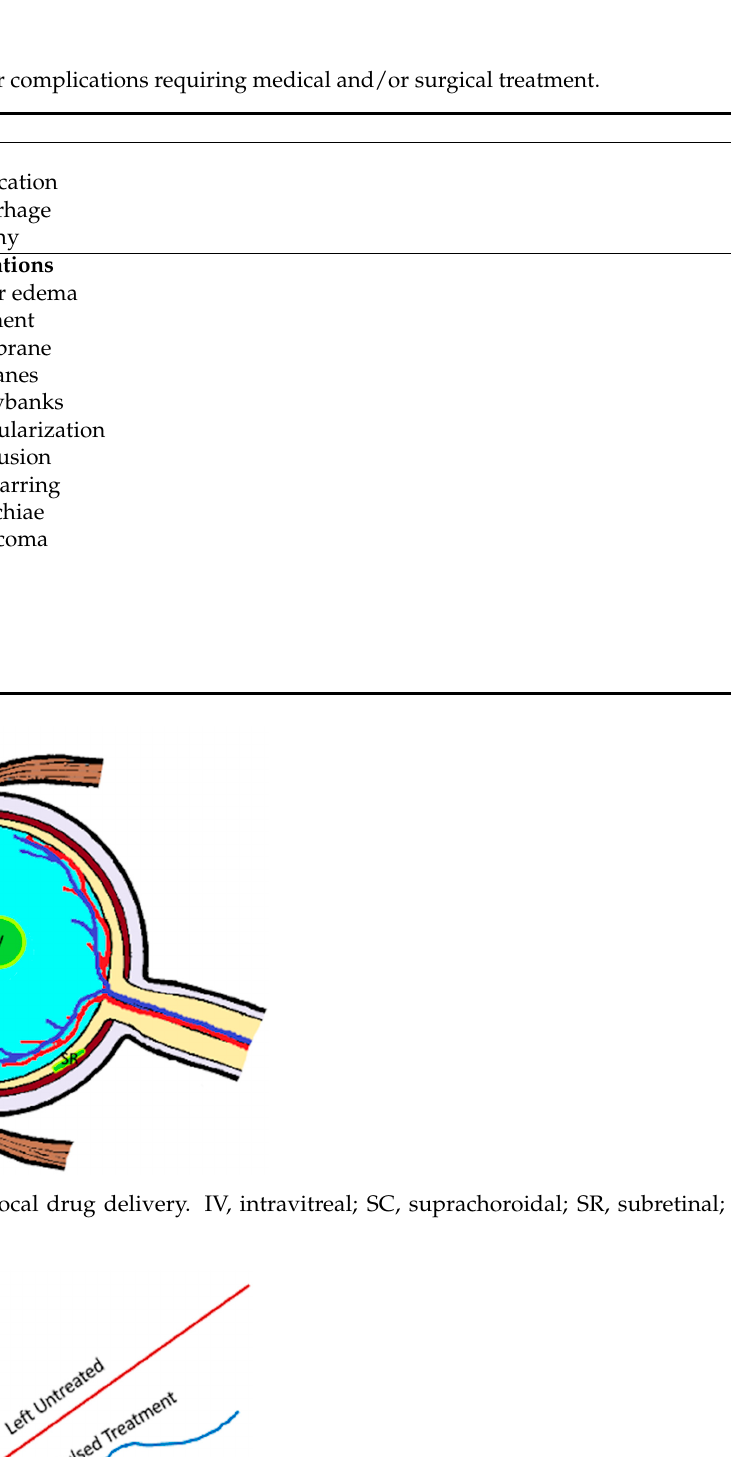
Table 1. Uveitic ocular complications requiring medical and/or surgical treatment.